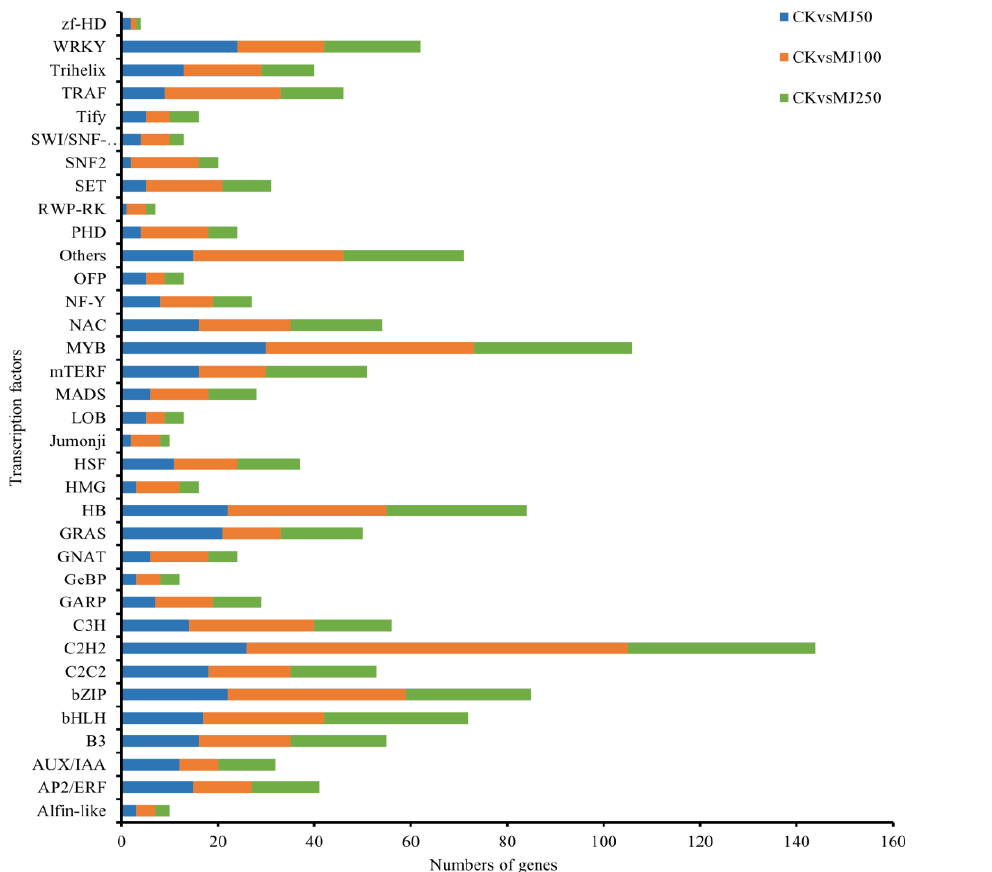
Figure 7. Identifcation and analysis of transcription factor gene expression levels in response to four MeJA treatments.